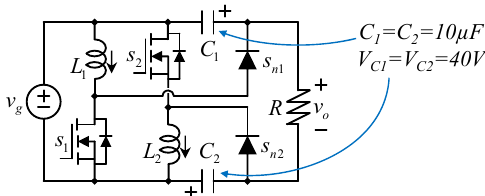
Figure 10. Solution with the topology in [9].